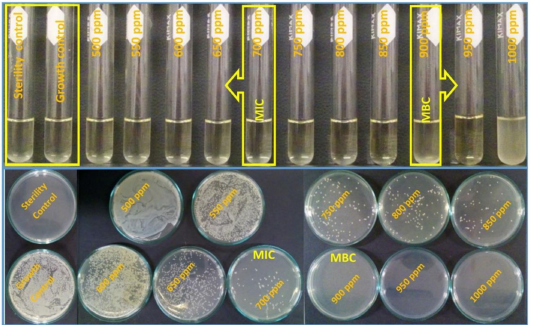
Figure 11. Staphylococcus aureus ATCC 25,923 exposed to different concentrations of MgO NPs. The upper photographs show that for concentrations of 650 ppm and below, there were many colony-forming units (CFU). MIC: 700 ppm; MBC: 900 ppm.